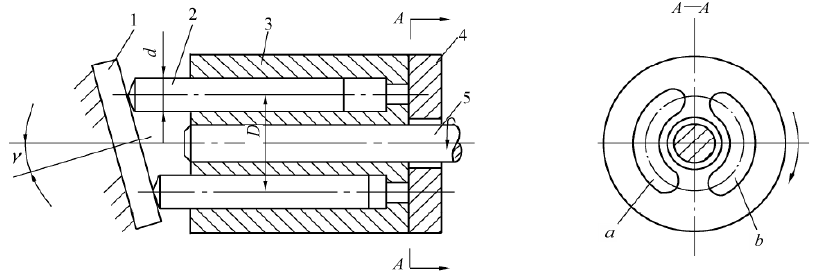
Figure 8. Structural schematic diagram of axial piston pump: 1—swashplate; 2—plunger; 3—cylinder block; 4—port plate; and 5—transmission shaft.